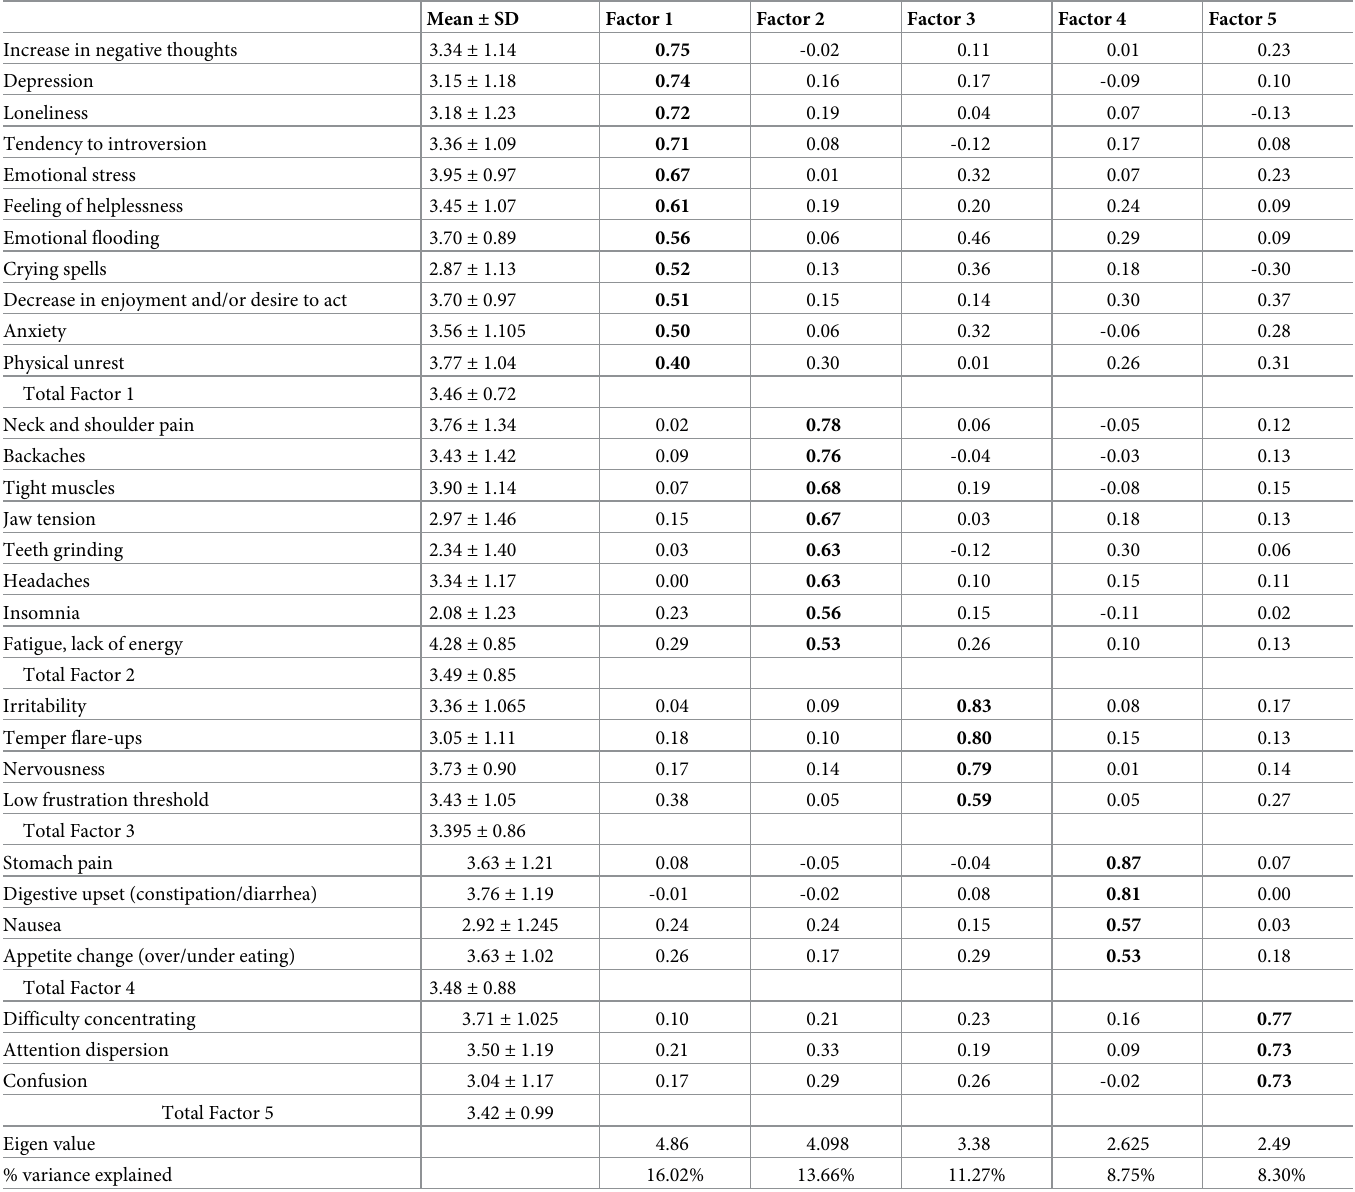
Table 2. Mean standard deviations and factor loadings of stress responses: Study